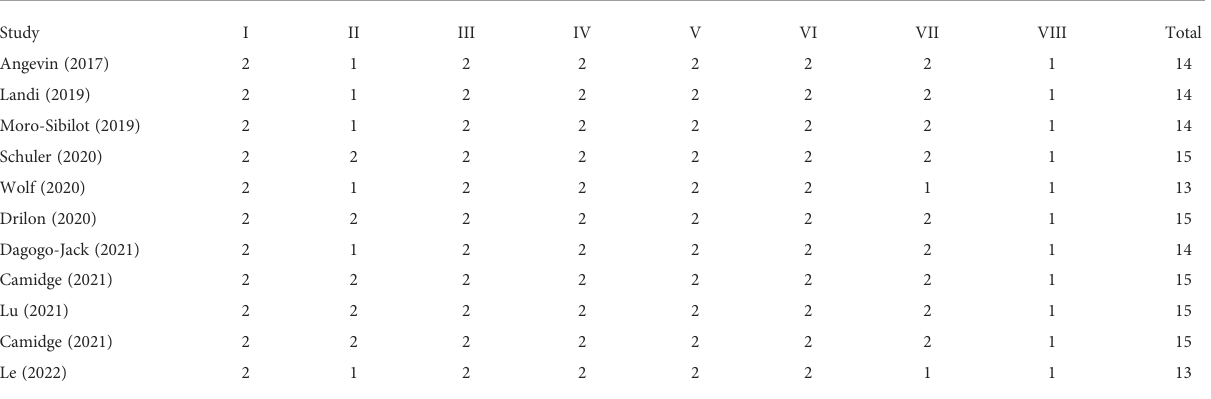
TABLE 2 Quality assessment of included studies. MINORS index for included non-randomized studies.